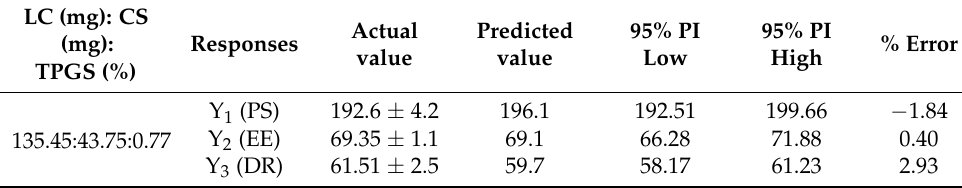
Table 4. Optimization by point prediction method and value at 95% PI low and 95% PI